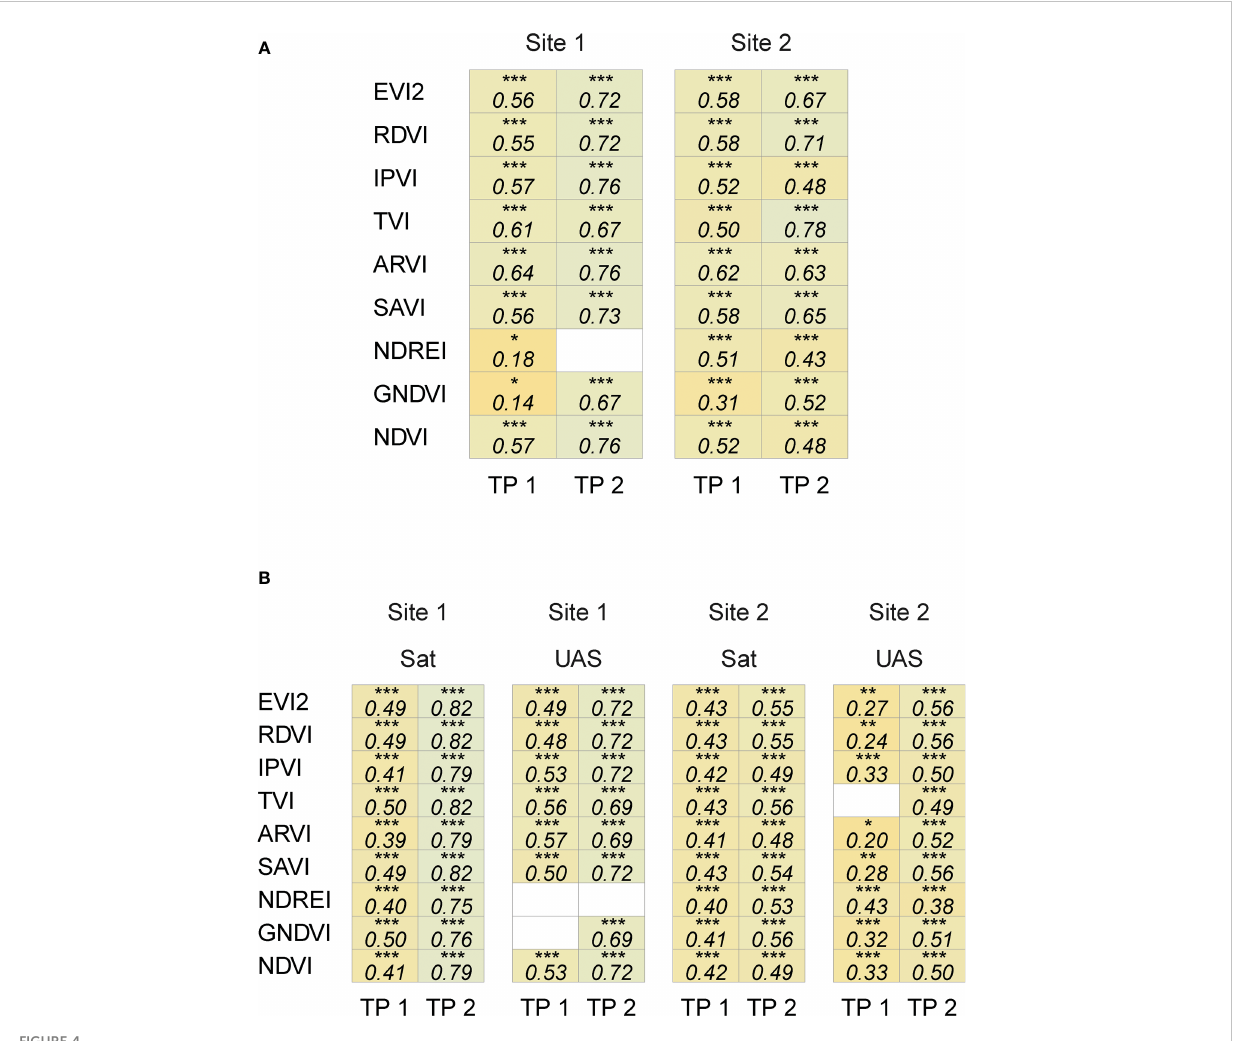
FIGURE 4 Correlation coef fi cient between spectral features extracted from satellite and UAS imagery (A) , and with seed yield (B) . White cells indicate non- signi fi cant correlation (p ≥ 0.05), *(0.01< p ≤ 0.05), **(0.001< p ≤ 0.01), and ***(p ≤